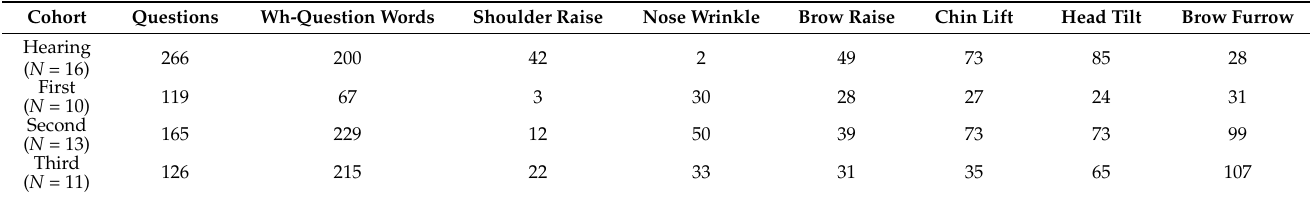
Table 3. Sum of questions, wh-question words, and non-manuals elicited by cohort.